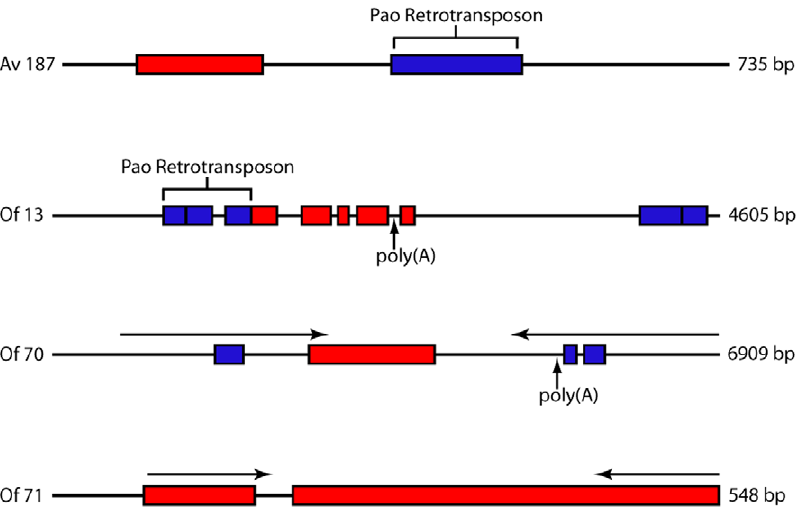
Figure 2. Schematic of genomic DNA fragments containing Wolbachia homologs. Figure outlines the structure of four genomic sequence fragments identified in this study. The exact annotation and coordinates of each of the homologs depicted can be found in Tables S1 and S2. Blue blocks represent regions of homology to nematode sequences while red blocks represent regions homologous to Wolbachia sequences. Horizontal arrows represent inverted repeats in the DNA sequence. Inverted repeat segments in Of70 share 88% identity with one another while the repeated segments in Of71 share 82.8% identity.